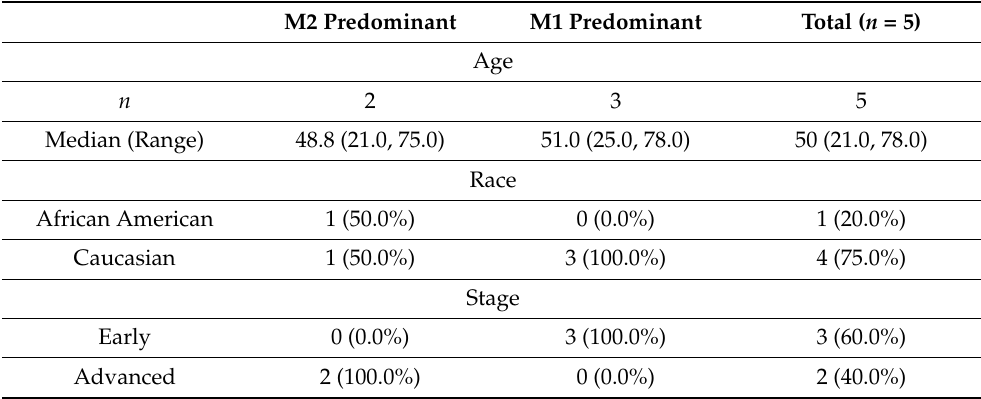
Table 2. Demographic and stage data by M1–M2